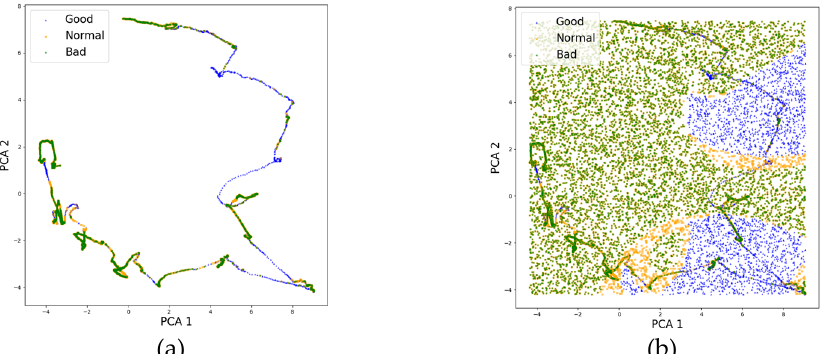
Figure 2. Scatter plots expressed in 2D through PCA: ( a ) training data and ( b ) random sampling added to ( a ).